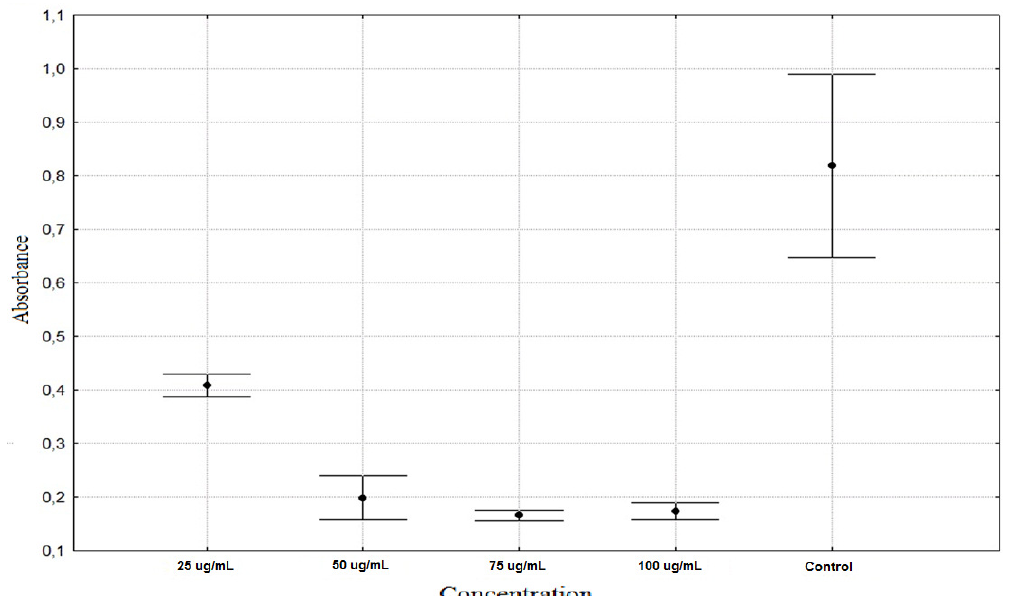
Figure 3. Antiproliferation activity of Tragopogon pratensis phenolic compounds on HaCaT cells (average ±